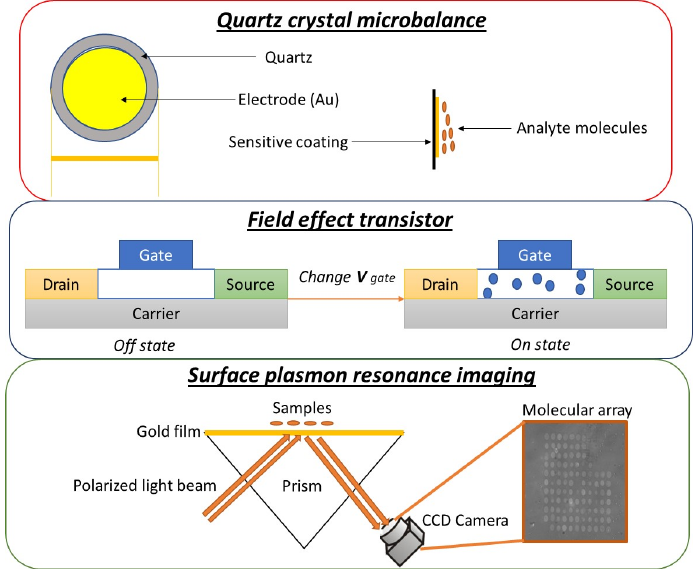
Figure 1. Sketch of the most used transducers in peptides, DNA and MIPs modified gas sensors.